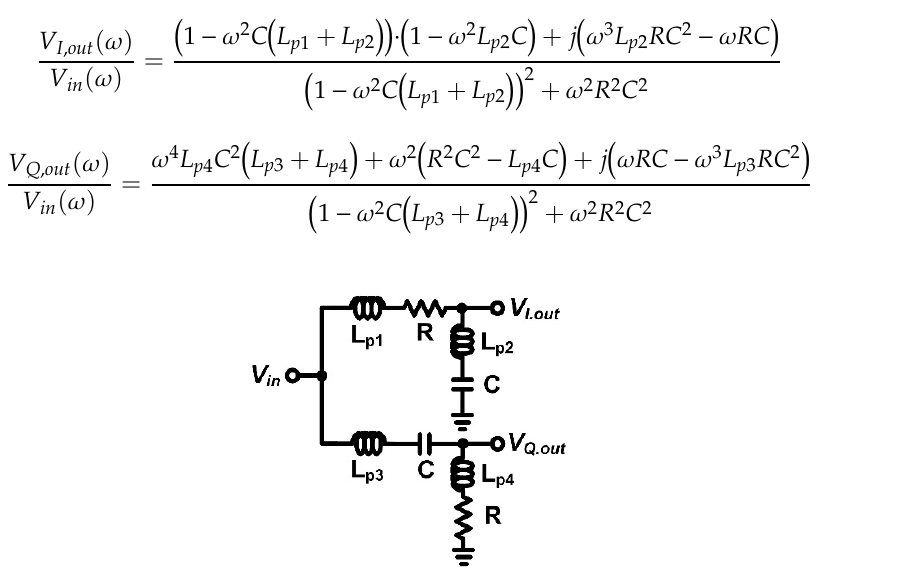
Figure 6. Simplified 1st - order poly-phase filter including parasitic line inductance by metal routing.